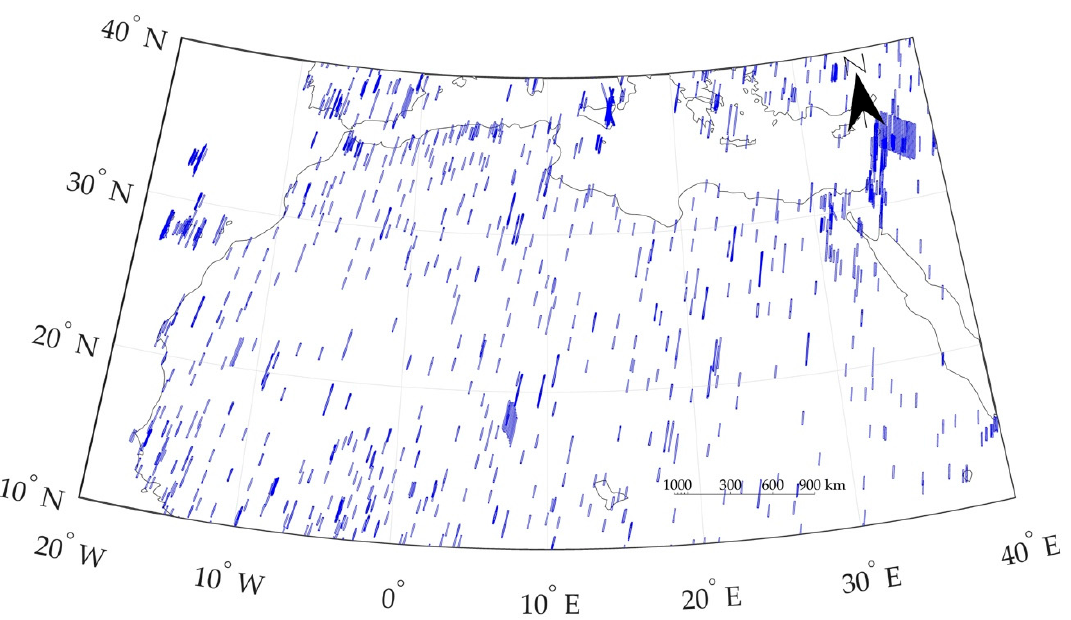
Figure 2. Hyperion coverage over North Africa.